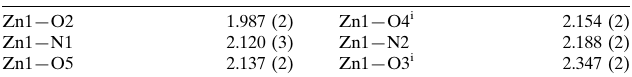
Selected bond lengths (A˚ ).